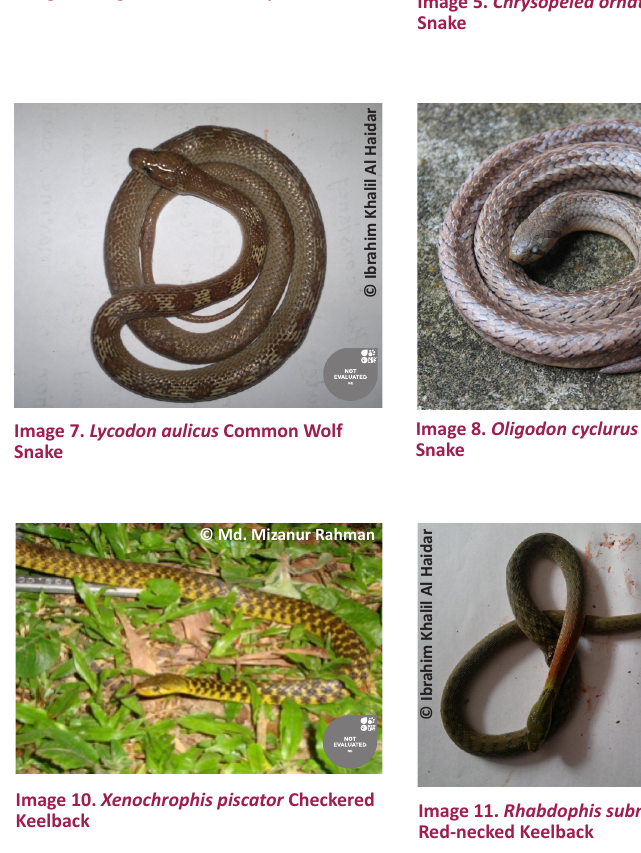
Image 12. Ptyas korros Indo-Chinese Rat